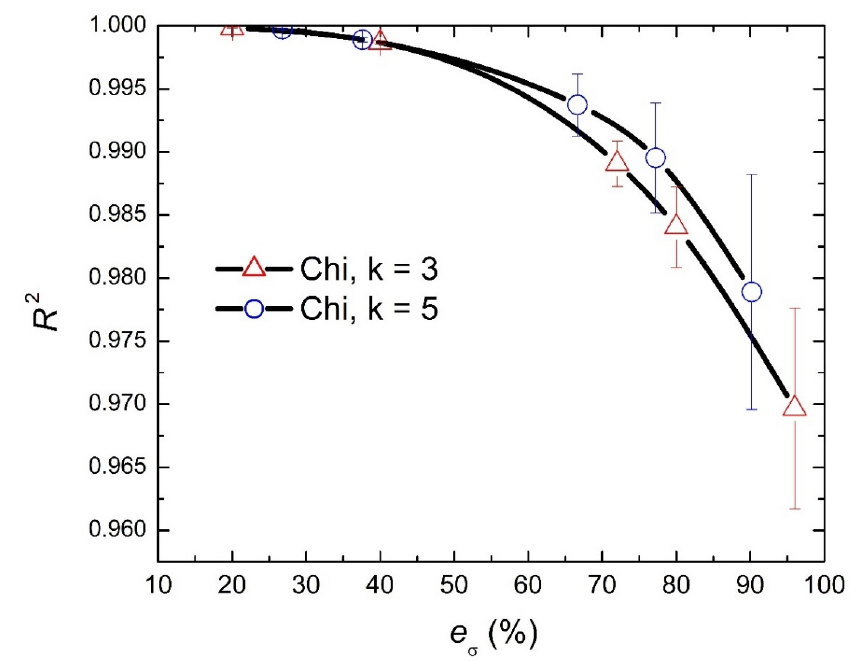
Figure 2. Coefficient of determination R 2 as a function of the dispersion of the SD of the Gaussian components (k = 3, 5). The points in the plot have been connected by means of RKHS interpolations [9,10].